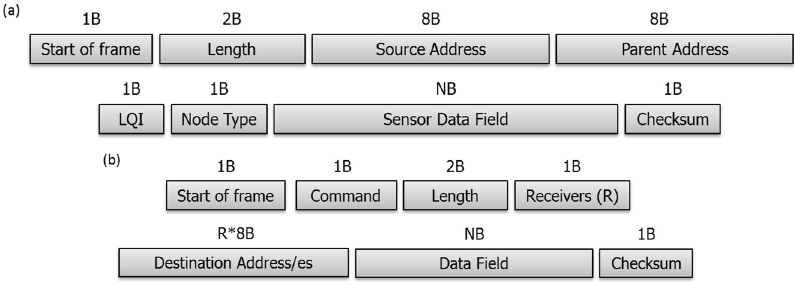
Figure 6. ( a ) WSAN sent frame format; ( b ) WSAN received frame format.